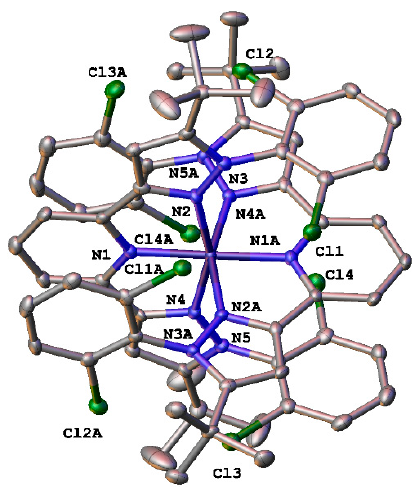
Figure 1. General view of the cation [Fe( L ) 2 ] 2+ in [Fe( L )] 2 (BF 4 ) 2 ·0.5H 2 O (red) from X-ray diffraction at 120 K. Hydrogen atoms are omitted for clarity, non-hydrogen atoms are shown as thermal ellipsoids (p = 50%), and only labels of the heteroatoms in an asymmetric part of the unit cell are given. For other solvatomorphs, see Figures S1 and S2.